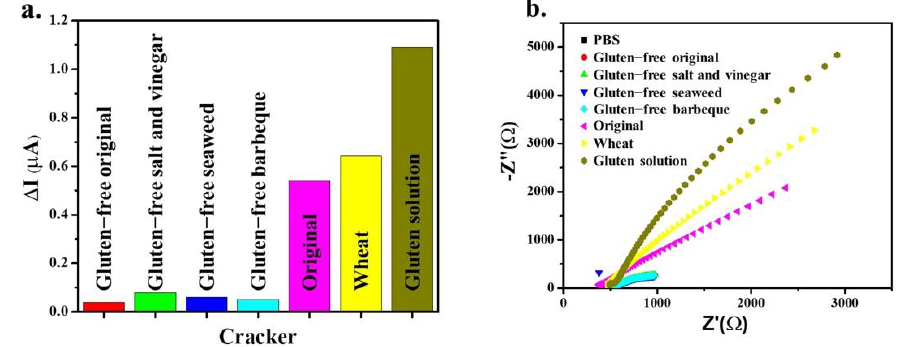
Figure 8. Current ( a ) and resistivity response ( b ) of the gluten in